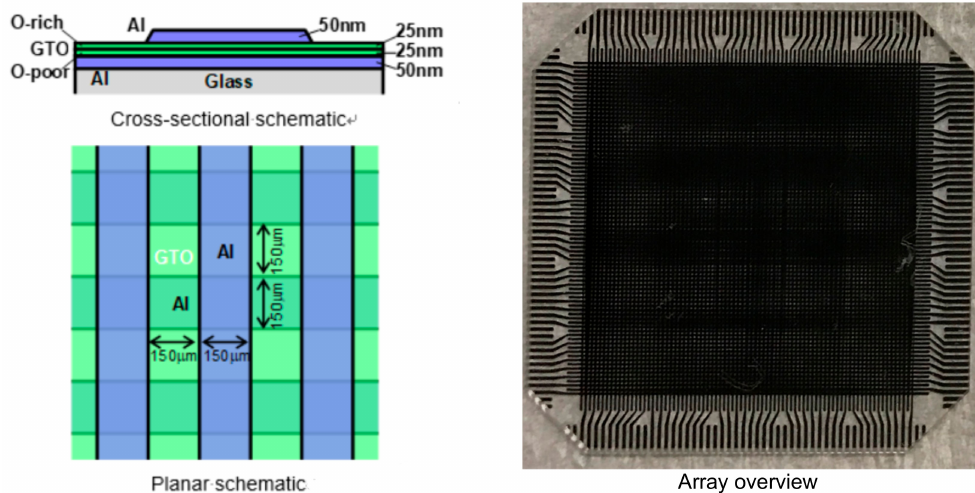
Figure 1. Device structure of the amorphous Ga-Sn-O ( α -GTO) thin-film device with double layers of di ff erent oxygen